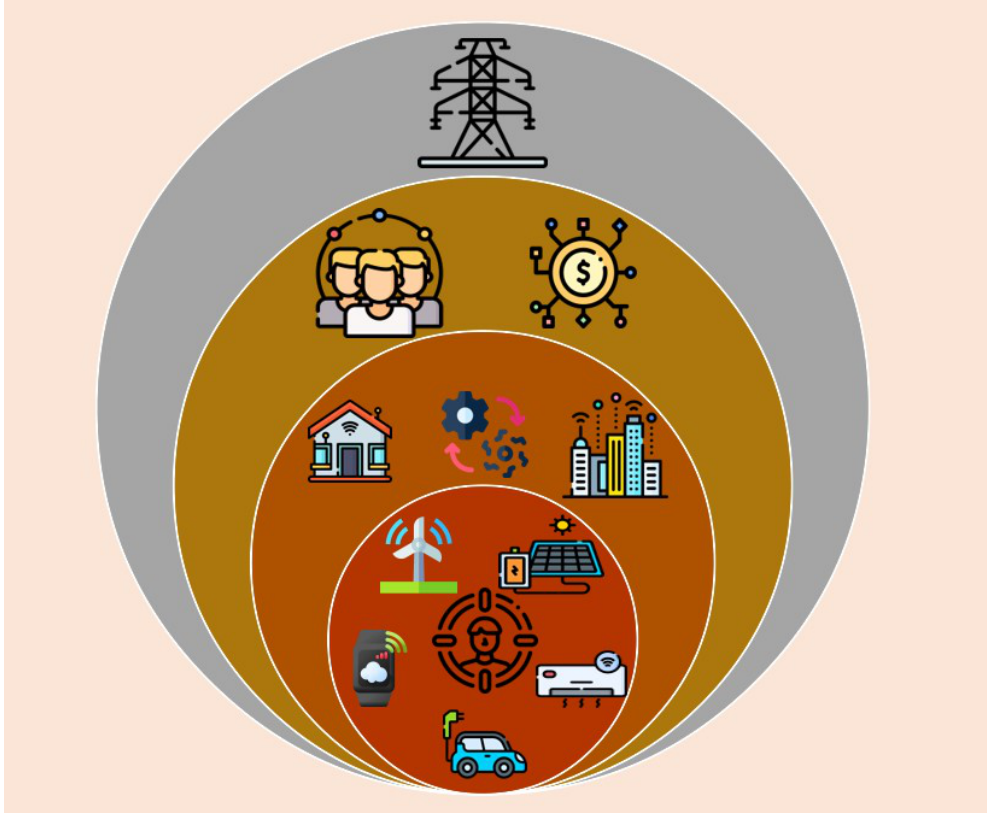
Figure 1. The consumer-centric structure of